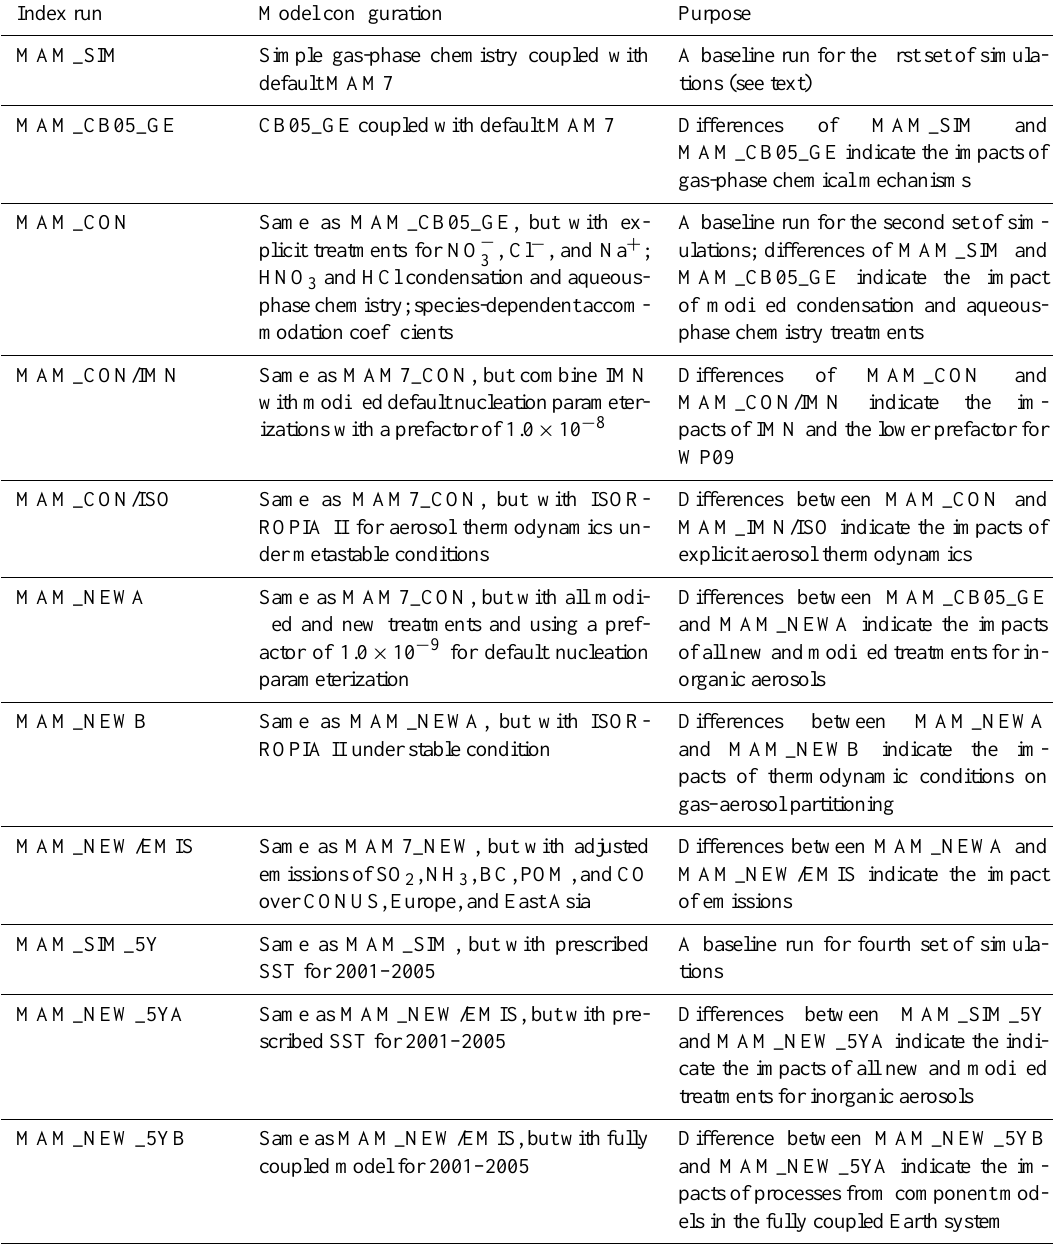
Table 1. Simulation design and